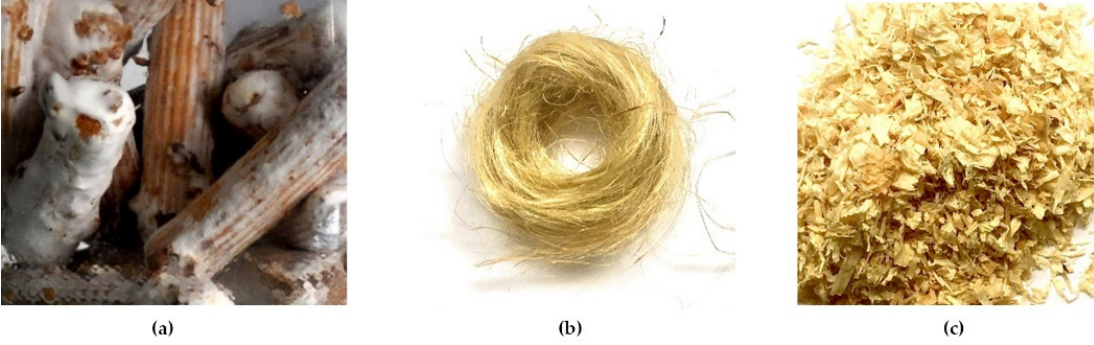
Figure 3. Mycelium-infused wood plugs ( a ); Hosting materials: hemp fibers ( b ), wood chips ( c ).